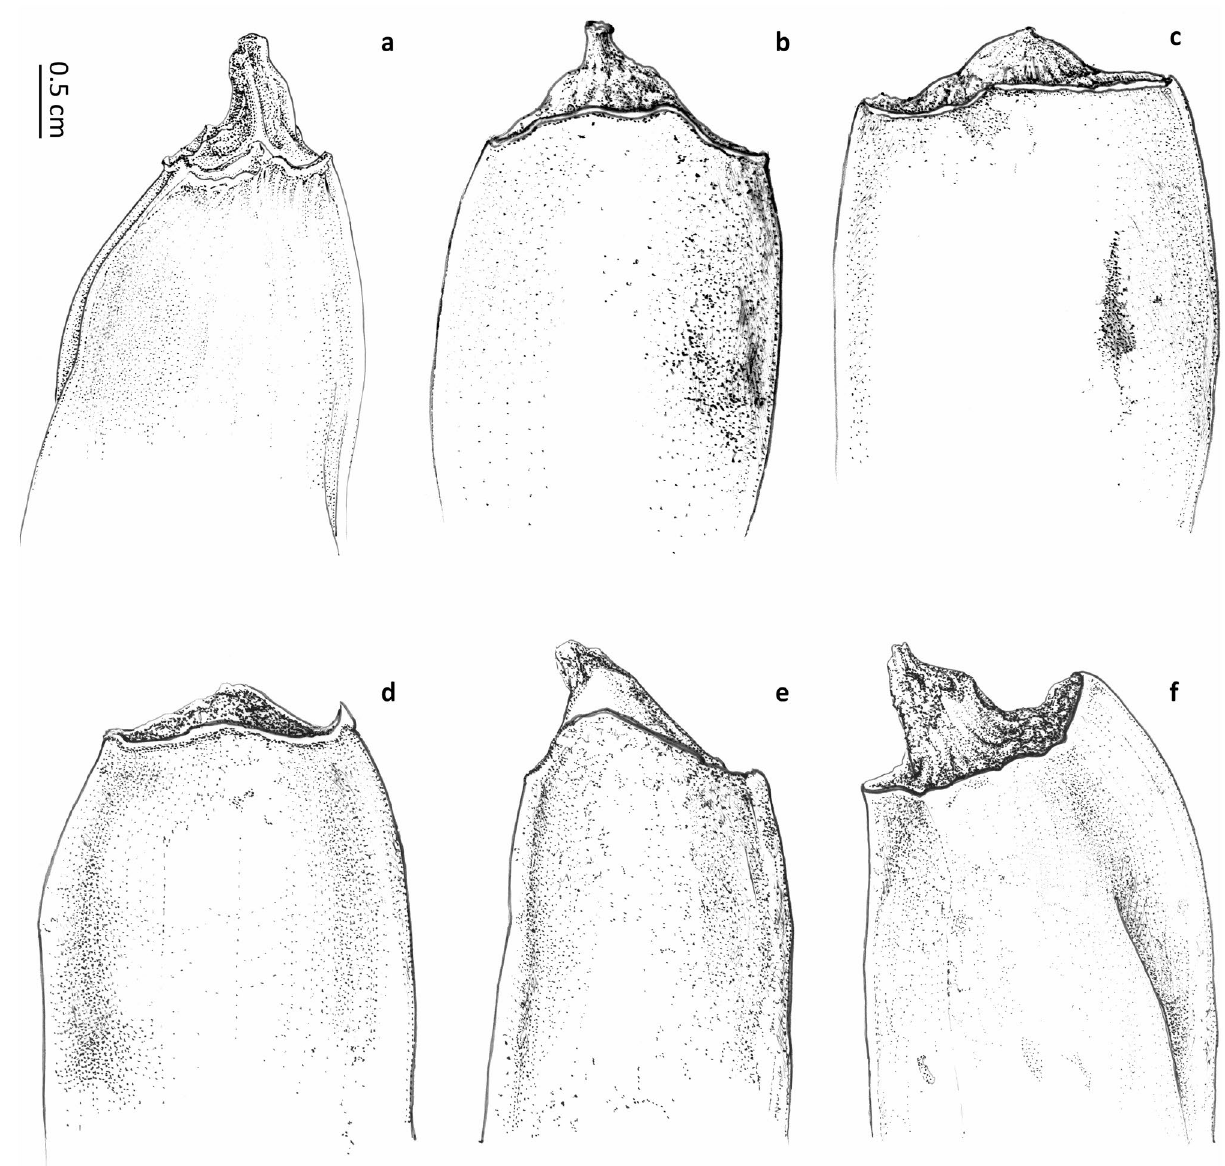
Figure 2. Comparison of non-opened fruit apices. ( a ) R. agatheae . ( b ) R. blancii . ( c ) R. hladikorum . ( d ) R. grandis . ( e ) R. madagascariensis . ( f ) R. menahirana . Ink drawings on 75 µ polyester tracing paper by Agathe